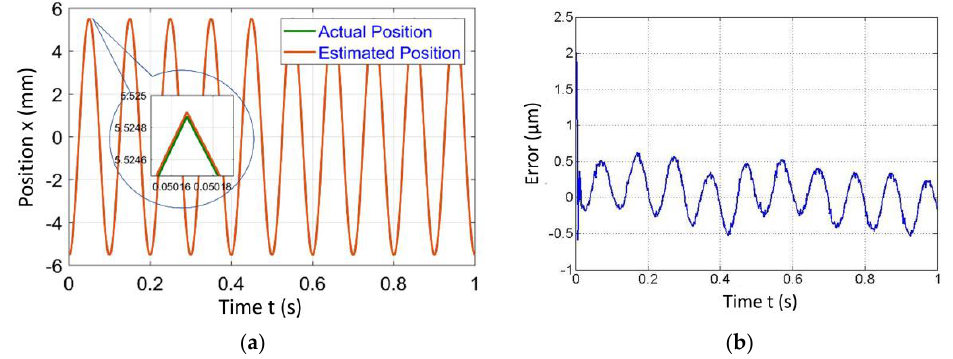
Figure 7. Simulated results of the position estimator algorithm at 10 Hz frequency for ( a ) Position comparison and ( b ) Error between actual and estimated position. Table 2. Summary of error at various frequencies.